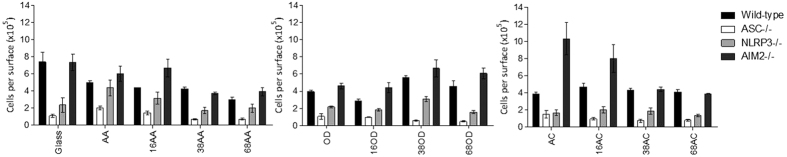
Bone marrow-derived macrophage (BMDM) adhesion on controlled nanotopography surfaces.BMDM cultured from wild-type, ASC−/−, NLRP3−/− or AIM2−/− mice were incubated on controlled nanotopography surfaces before being fixed, stained with DAPI for the quantification of nuclei to deduce the total cell numbers per surface. Results are expressed as mean ± SEM and are representative of two independent experiments. The p values were calculated in reference to the glass control surfaces for each murine genotype using a one way analysis of variance with a Dunnett’s post-test. There was no significance obtained amongst the comparisons (p < 0.05).